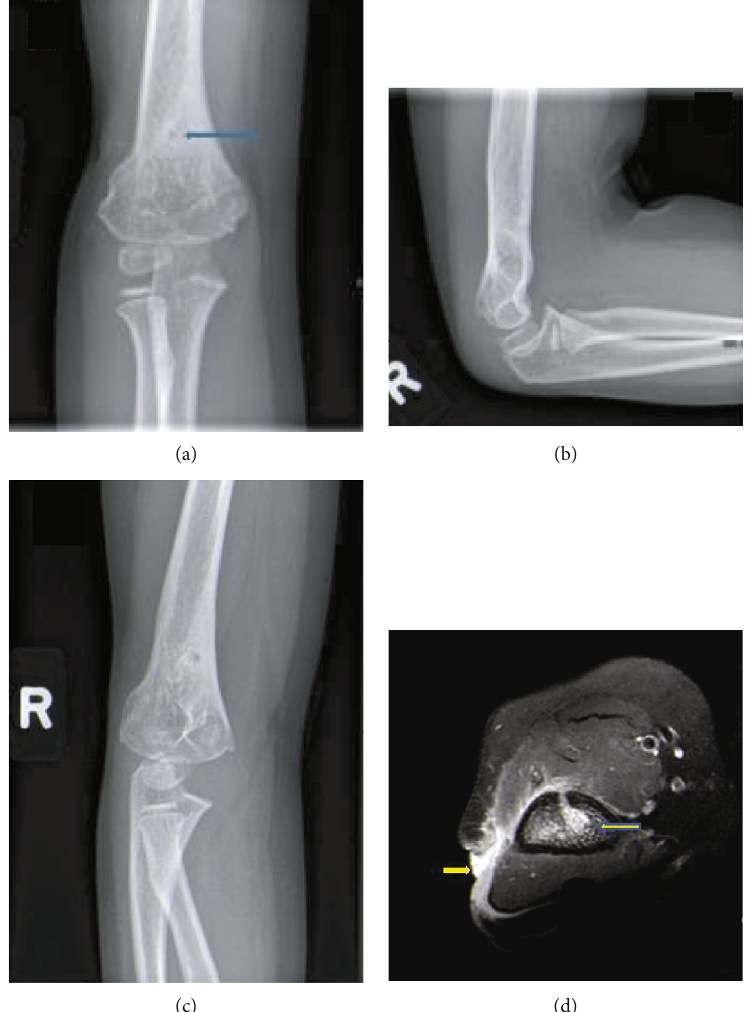
Figure 1: (a – c) AP, lateral, and oblique MRI of the right elbow with a subtle area of lucency (arrows) in the metaphysis. (d) Axial T1 postcontrast MRI with an enhancing lesion (large arrow) in the bone with anterior cortical disruption and enhancement anterior to the humerus extending to the lateral sinus tract (small